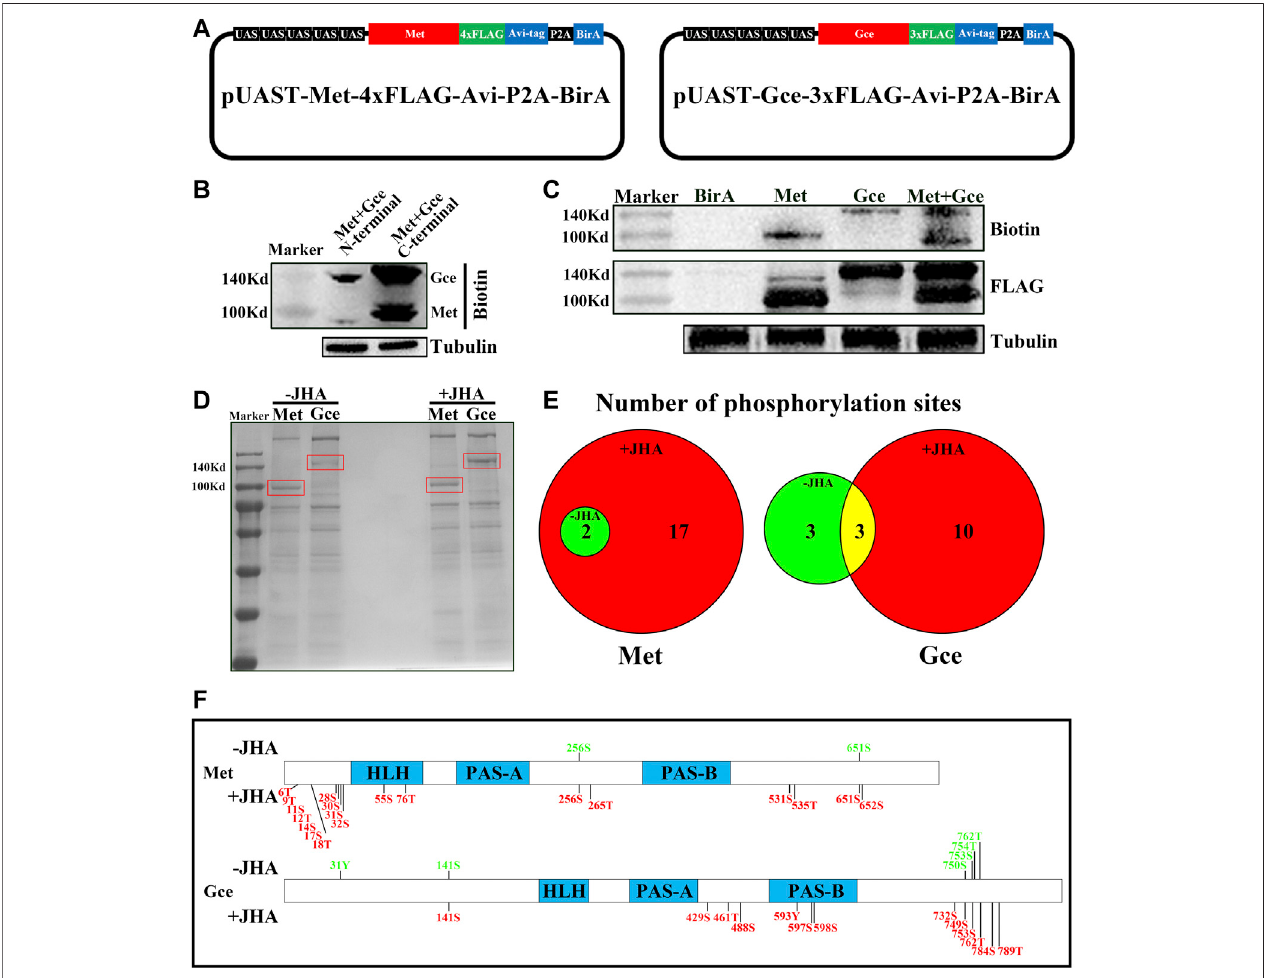
FIGURE 2 | Identi fi cation of phosphorylation sites in Met and Gce in vitro via a biotinylation tagging approach. (A) Schematic diagram of the UAS-Met-BirA and UAS-Gce-BirA constructs for in vitro biotinylation. (B) Effect of BirA fused to either C-terminus or N-terminus of Met and Gce on the yield of the two proteins. (C) Double validationofMetorGceexpression bybothbiotinandFLAG antibodies.Thetubulinproteinwasusedasaloadingcontrol. (D) Separationofphosphorylatedproteinsby coomassie blue staining after immunoprecipitation of the protein extracts from Met-BirA or Gce-BirA overexpressing cells. Met and Gce bands (in red frame) were excised for protease digestion and mass spectrometry. (E) Venn diagram showing the numbers of phosphorylation sites that were identi fi ed for either Met or Gce, with regardtoJHAtreatment. (F) Distributionoftheidenti fi edphosphorylationsitesinMetandGce.Thesitesingreenindicatebasalphosphorylationsites(2forMetand3for Gce) in consistent with those in (E)